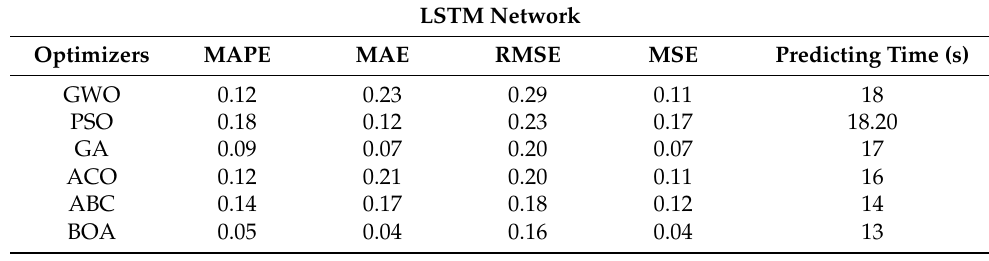
Table 6. Performance of the dissimilar hyperparameter optimizers in the LSTM network on the IHEPC dataset.